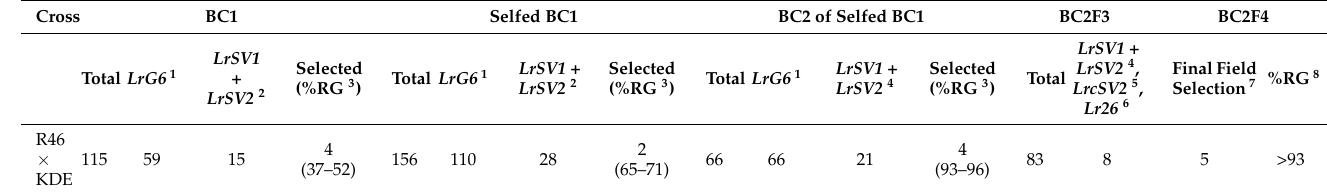
R46 × R.Siriri Table 7. Introgression into KDE. Number of plants selected in each cycle. 1 Selected by seedling resistance to P. triticina race Ca04KDE; 2 selected by their associated AFLP markers P31/M42 and P31/M37, respectively; 3 percentage of recurrent parent genome, calculated as described in Materials and Methods; 4 selected by their associated markers gwm261 and gwm533, respectively; 5 selected by its associated marker gwm149; 6 selected by its associated marker SCAR SCSS30.2; 7 selected by rust resistance, phenotypic characteristics of height, plant architecture, stem thickness and spike size by comparison with the original commercial variety and homogeneity; 8 minimum %RG according to the BC2 %RG. Cross Selfed